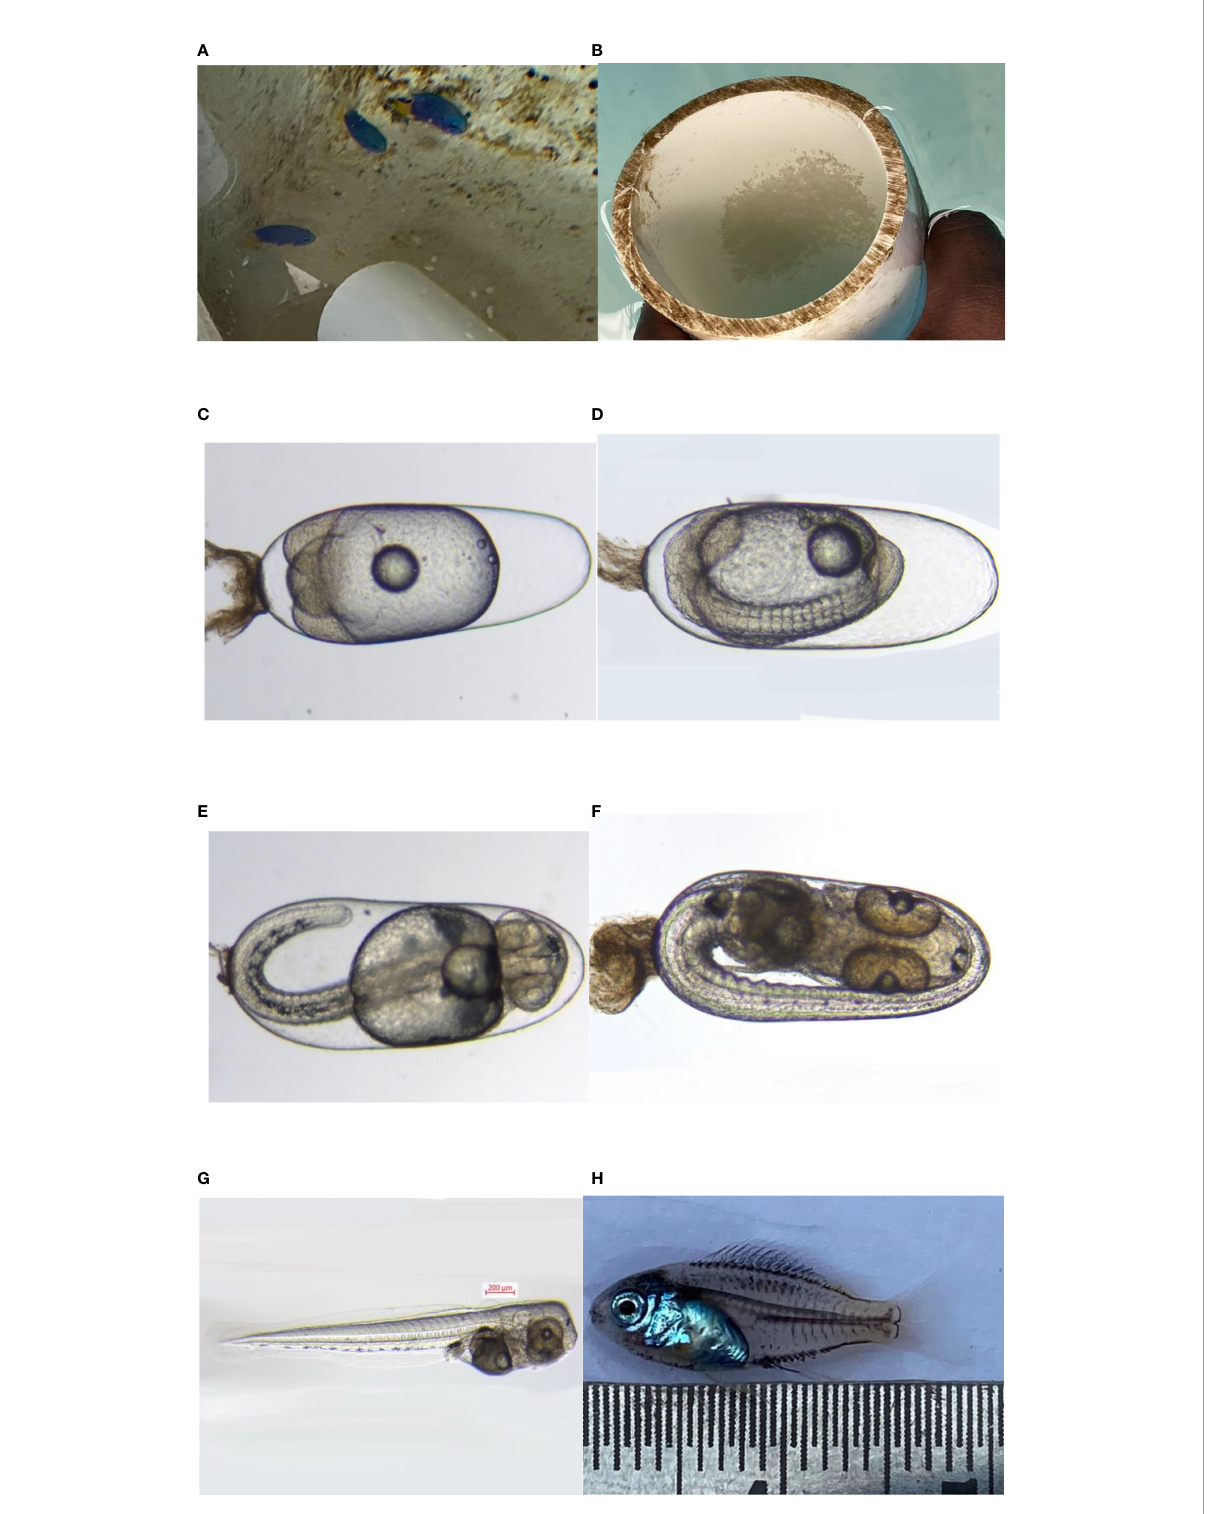
FIGURE 5 (A) P. caeruleus broodstock, (B) egg in substratum, (C) egg (day 1), (D) egg (day 2), (E) egg (day 3), (F) egg (day 4), (G) newly hatched larva, and (H) juvenile 27